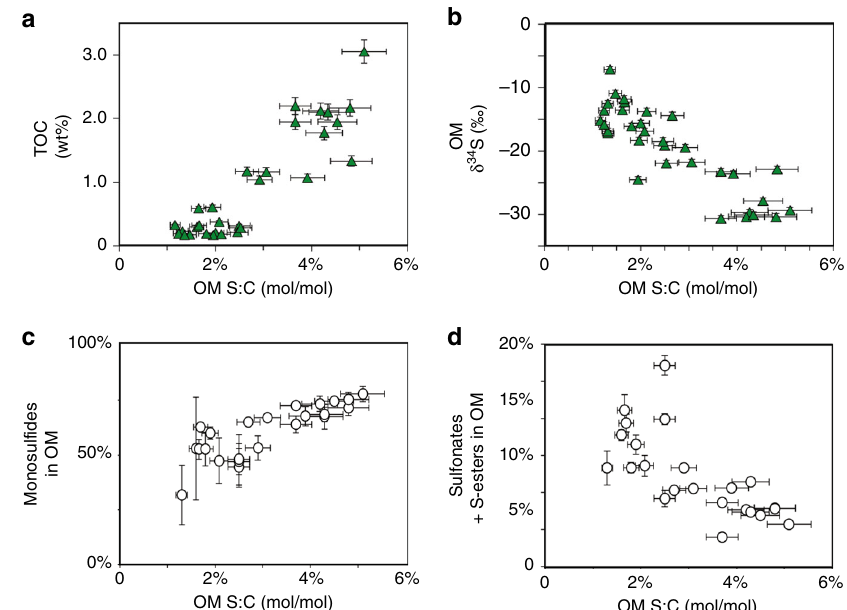
Fig. 3 Relationships between the molar S:C ratio of OM and other S org characteristics. a TOC concentration, b OM δ 34 S value, and the relative abundances of c monosul fi des and d oxidized (sulfonate + sulfate ester) S org in OM. Relative uncertainties (1 s.d.) on S:C ratios are calculated from propagation of error from the reproducibility of external replicate ( n ≥ 3) tests. Uncertainties for XAS data are from spectrum fi tting (1 s.d., Supplementary Table